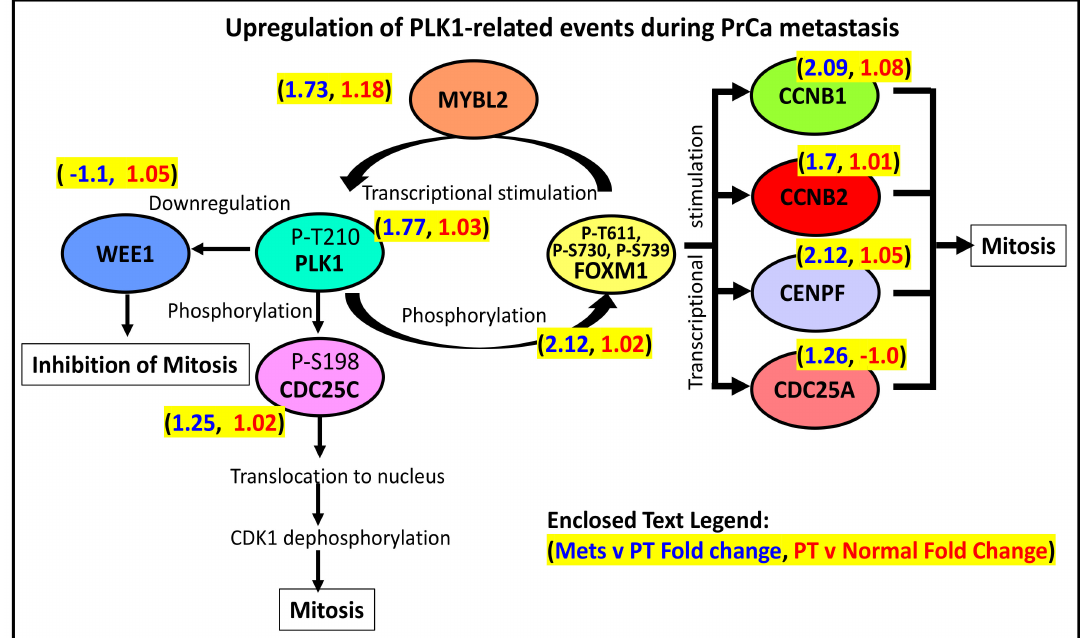
Figure 3. PLK1’s role in the regulation of